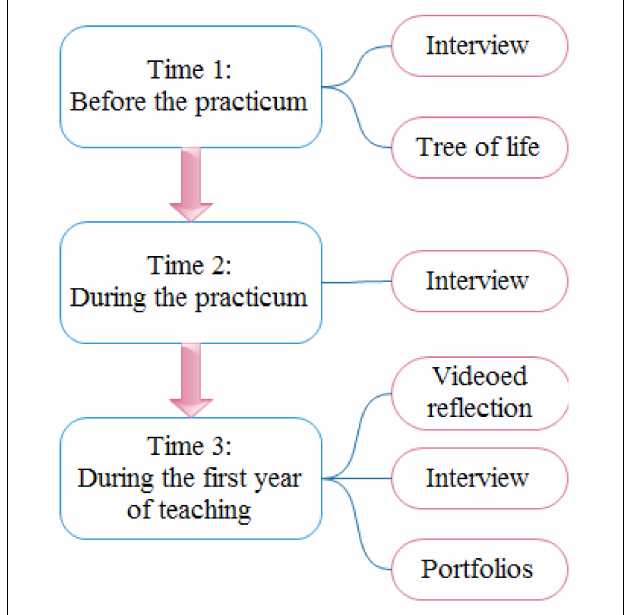
FIGURE 1 | Data collection instrumentation in different phases of